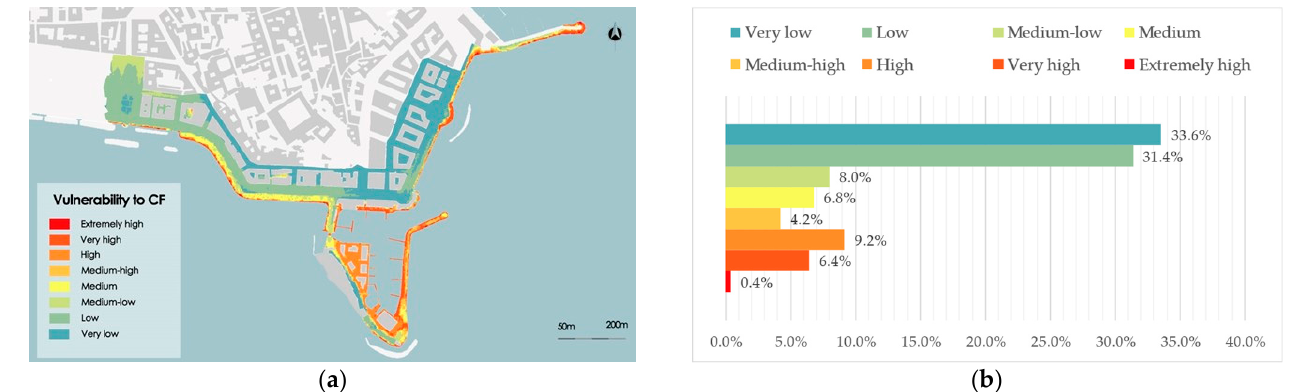
Figure 5. ( a ) Maps of the vulnerability to coastal flooding; ( b ) histogram of vulnerability classes distribution.